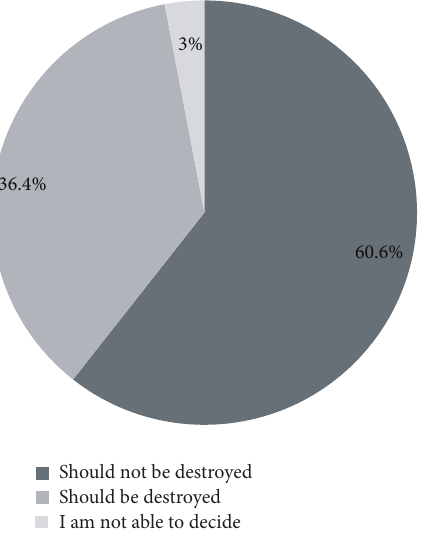
Figure 2: Participants’ professional background. The bar chart depicts the professional background of participants who answered the various categories on variola virus stocks destruction. Clinicians were equally divided in their opinion on destruction (50%) and preservation (50%) of the remaining variola virus stocks. Majority of the basic science researchers voted for preservation of the variola virus stocks